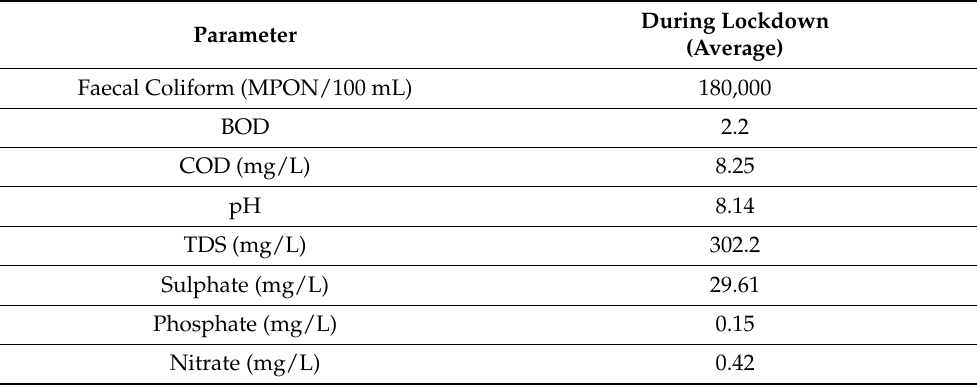
Table 2. Average concentration/value of different parameters at six locations during lockdown period in lower reaches of Ganges